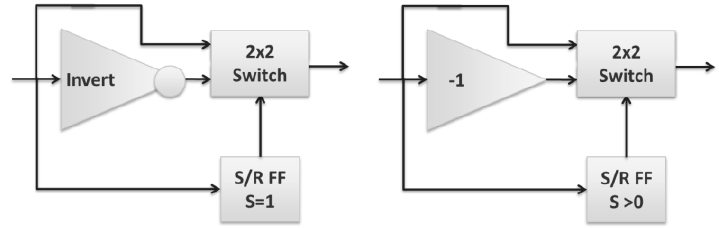
Figure 18. Extending hop count decrement from binary ( left ) to multi-bit data ( right ).